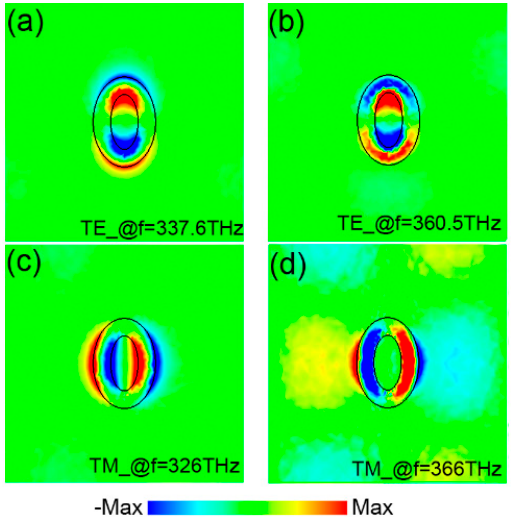
Figure 3. Electric-field distributions at resonant frequencies in the xoz plane ( z =45 nm). TE-polarized wave at ( a ) f = 337.6 THz and ( b ) f = 360.5 THz. TM-polarized wave at ( c ) f = 362.0 THz and ( d ) f = 366.0 THz.